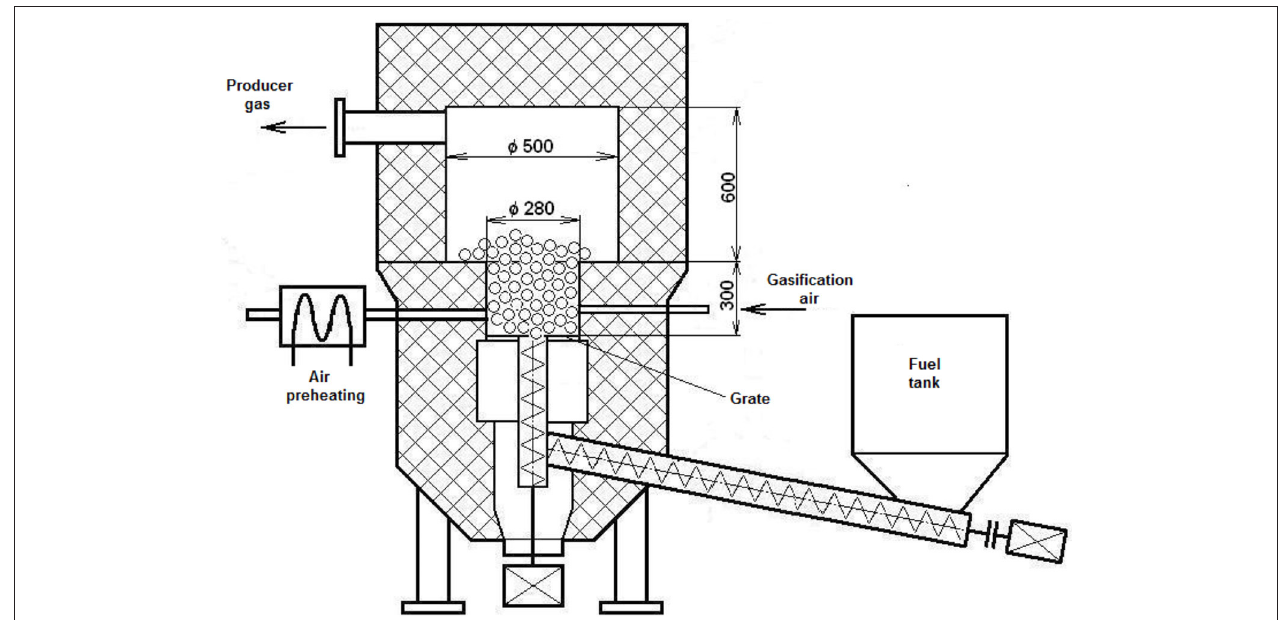
FIGURE 2 | Pellet Feeding System and Gasification Chamber.